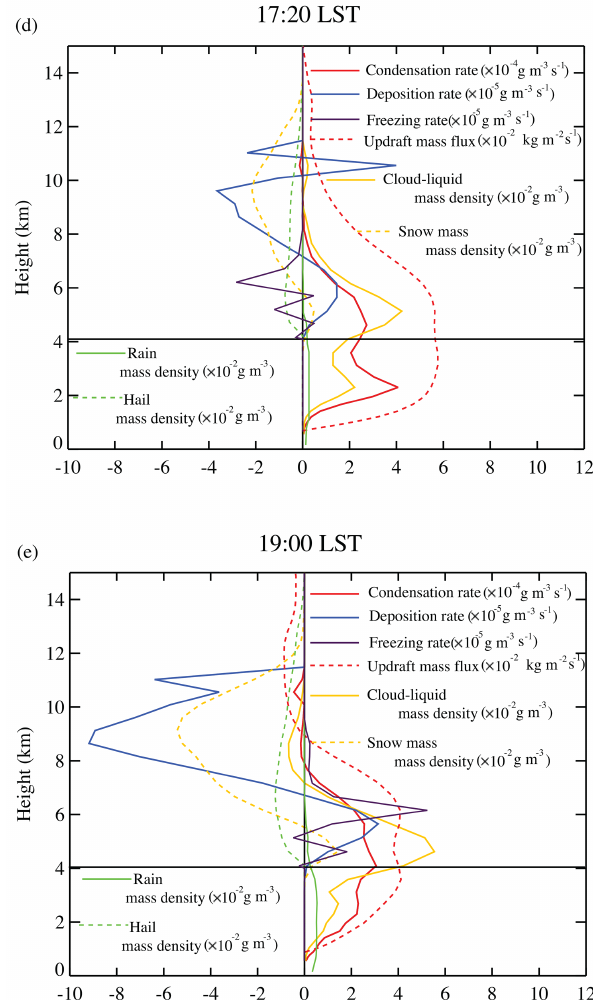
Figure 10. Same as Fig. 6 but for differences between the control-b and low-aerosol-b runs at (a) 14:20LST, (b) 15:40LST, (c) 16:00LST, (d) 17:20LST and (e) 19:00LST.